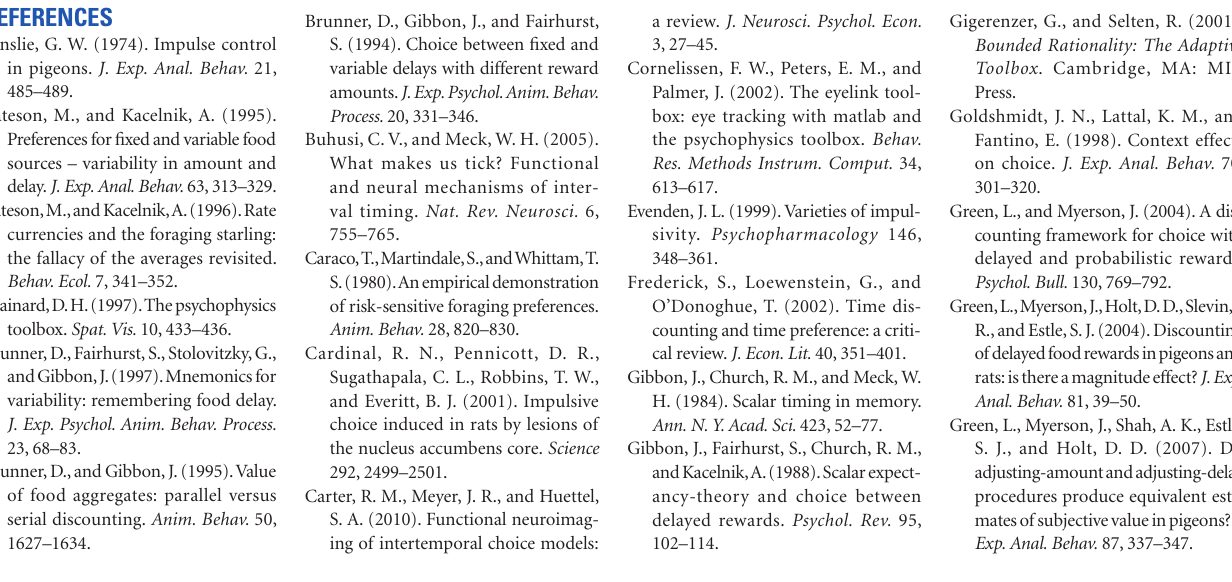
condition. Cued, combined refers to data pooled across the two cued conditions for each subject. Final uncued data for Monkey O were collected after an extended hiatus from testing. Error bars represent 95% confidence intervals for the means, calculated by bootstrap